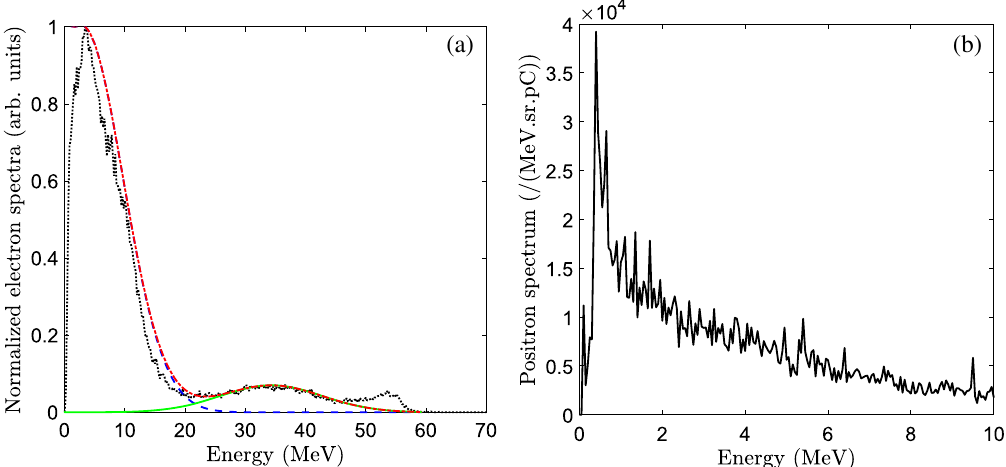
FIG. 10. (a) Normalized electron spectra: electron energy distribution predicted by the PIC simulation (black dotted line), low-energy (blue dashed line) and high-energy (green solid line) fitting of the electron distribution, and their sum of (red dotted dashed line). (b) Resulting simulated positron spectrum at the detector plane, per steradian and per pC of initial electron charge.